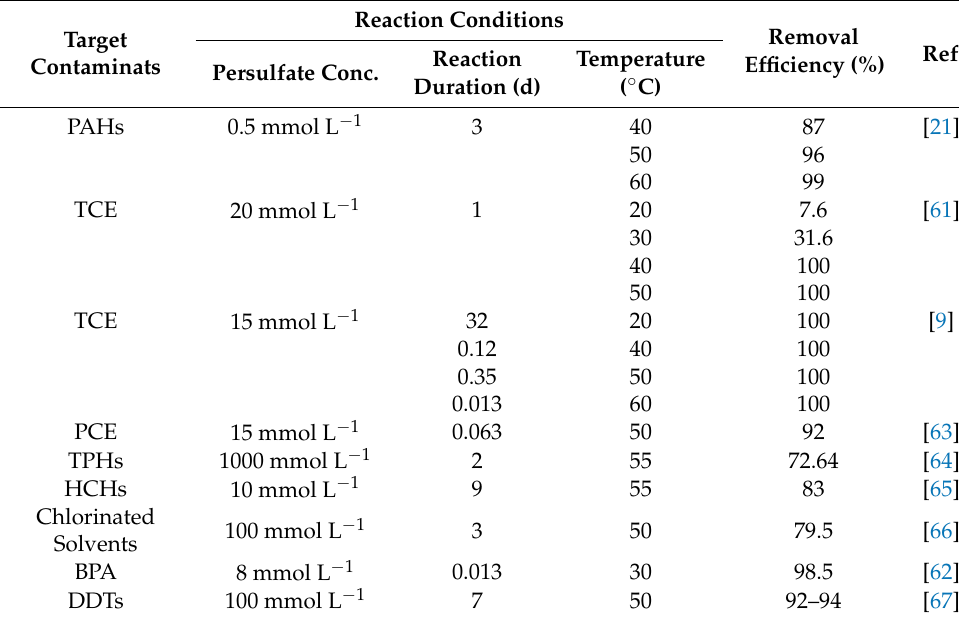
Table 1. Bench scale and laboratory studies with heat-activated